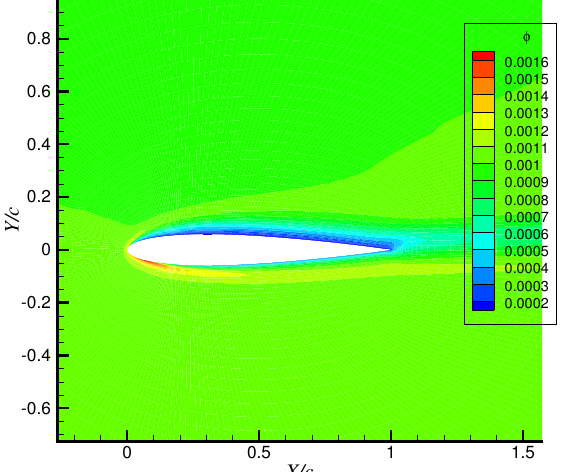
Figure 7. Droplet volume fraction diagram.